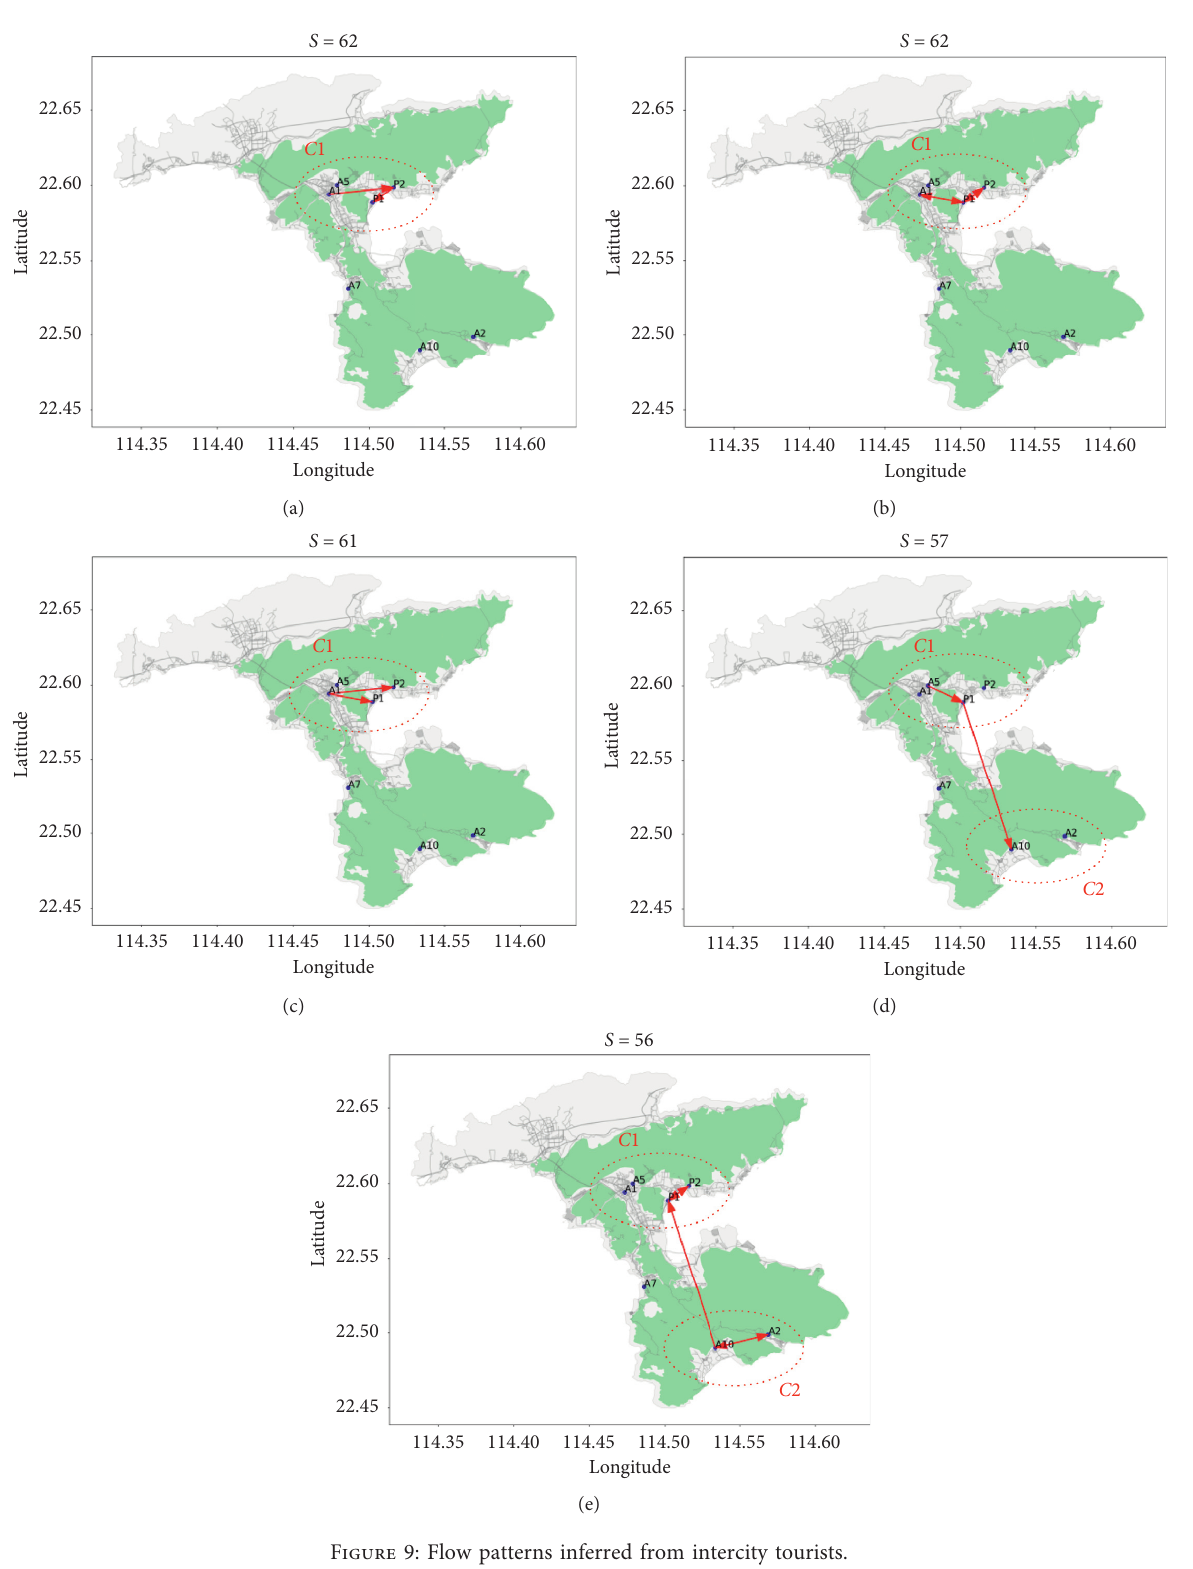
Figure 9: Flow patterns inferred from intercity